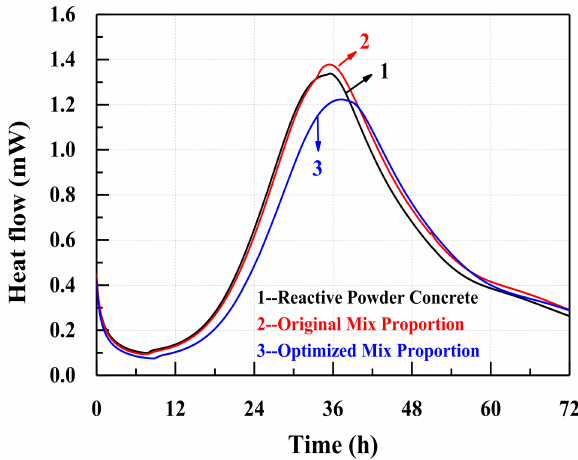
Figure 14. The heat flow test of the three different